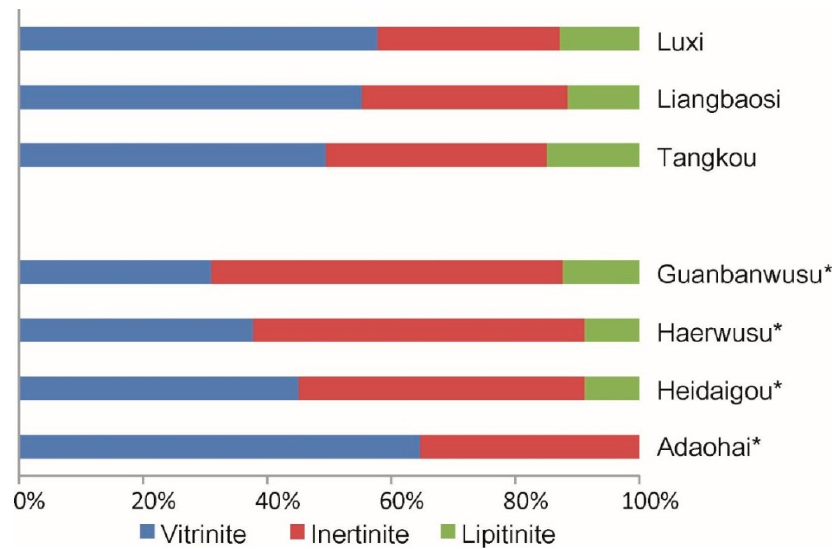
Figure 4. Maceral proportions of the three Upper No.3 coals from the Luxi, Liangbaosi, and Tangkou mines, as well as the coals from the Guanbanwusu [29], Haerwusu [30], Heidaigou [31], and Adaohai [32] mines.